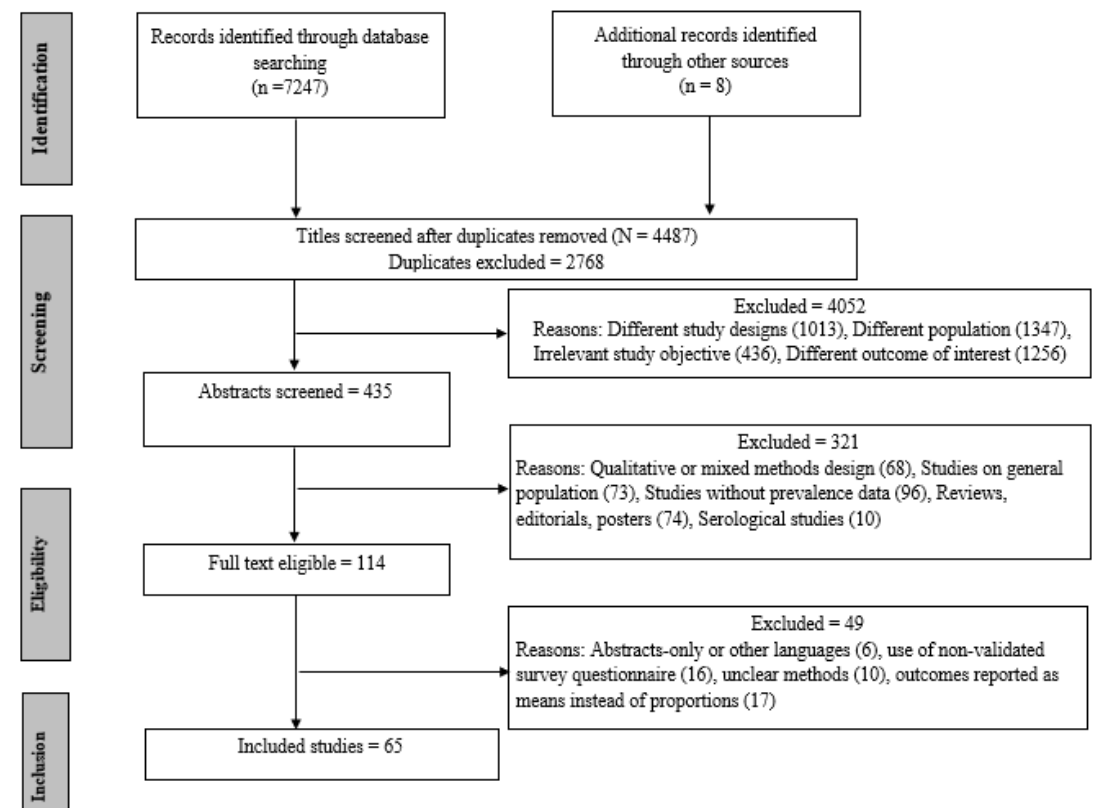
Figure 1. PRISMA (Preferred Reporting Items for Systematic Reviews and Meta-Analysis) flow diagram detailing the disposition of screened, included, and excluded